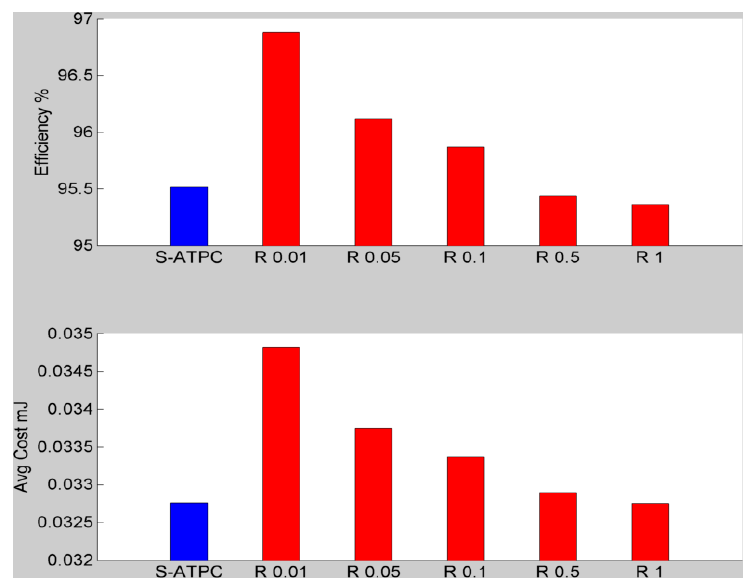
Figure 4. Activity level: moderate—the protocol efficiencies and the average cost of success transmissions are compared when the PSR for all the cases are equal to 100%.